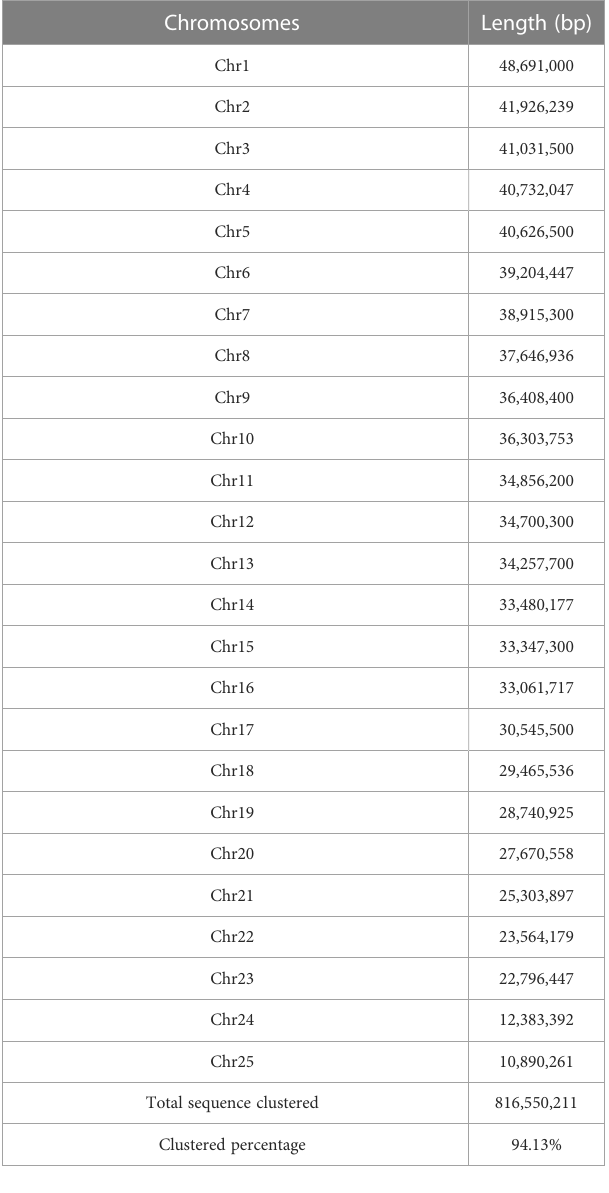
TABLE 3 Summary of assembled 25 chromosomes of O. cubicus